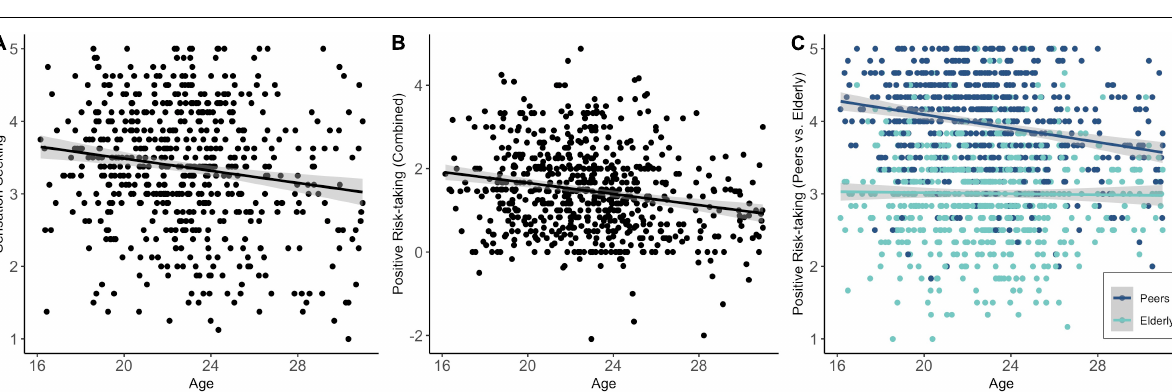
p = 0.028, η 2 = 0.01). No gender differences in life satisfaction were found ( F = 0.01, p = 0.973, η 2 = 0.00).